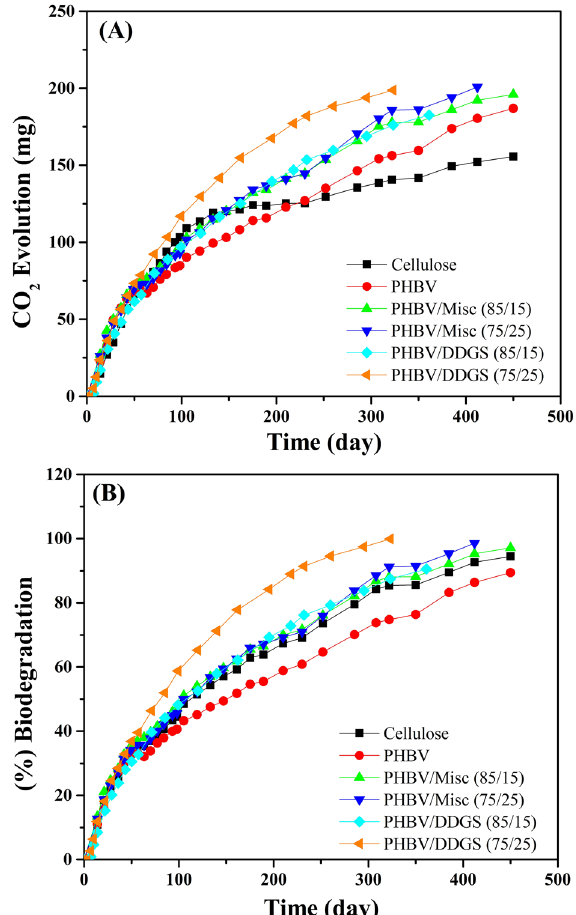
Figure 4. ( A ) CO 2 evolution and ( B ) overall biodegradation for cellulose, PHBV, PHBV/Misc and PHBV/ DDGS